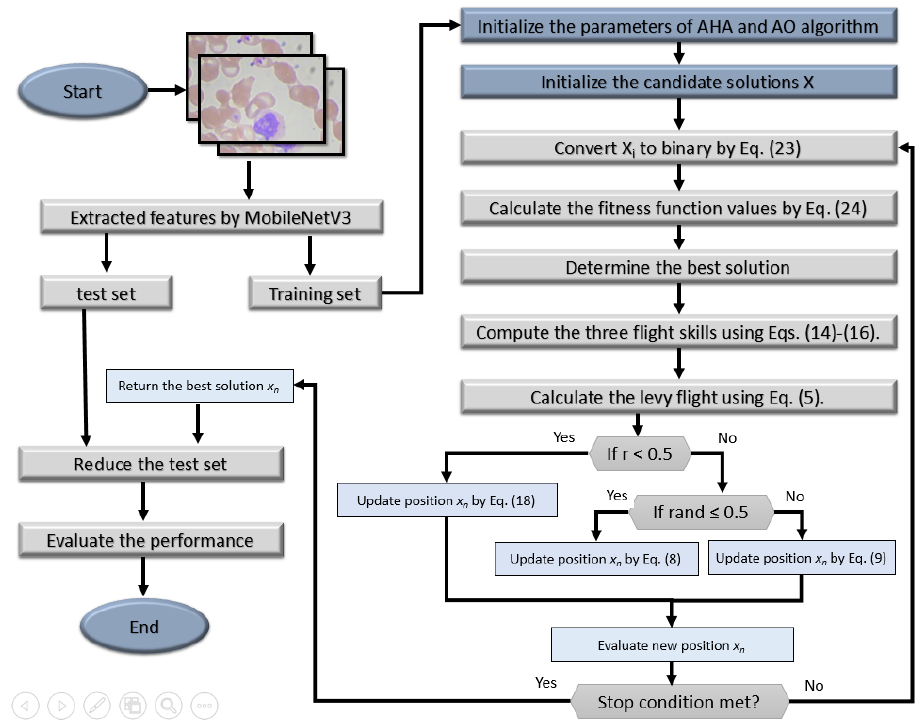
Figure 4. The architecture of the proposed AHA-AO for the FS